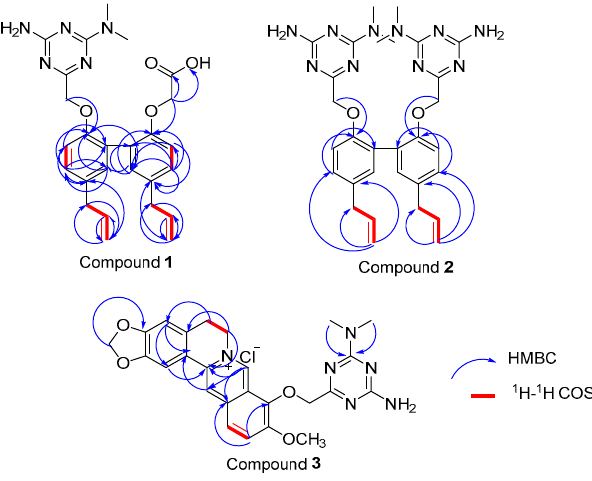
Figure 4. Key heteronuclear multiple bond correlation (HMBC) and 1 H- 1 H COSY correlations of compounds 1 – 3 .